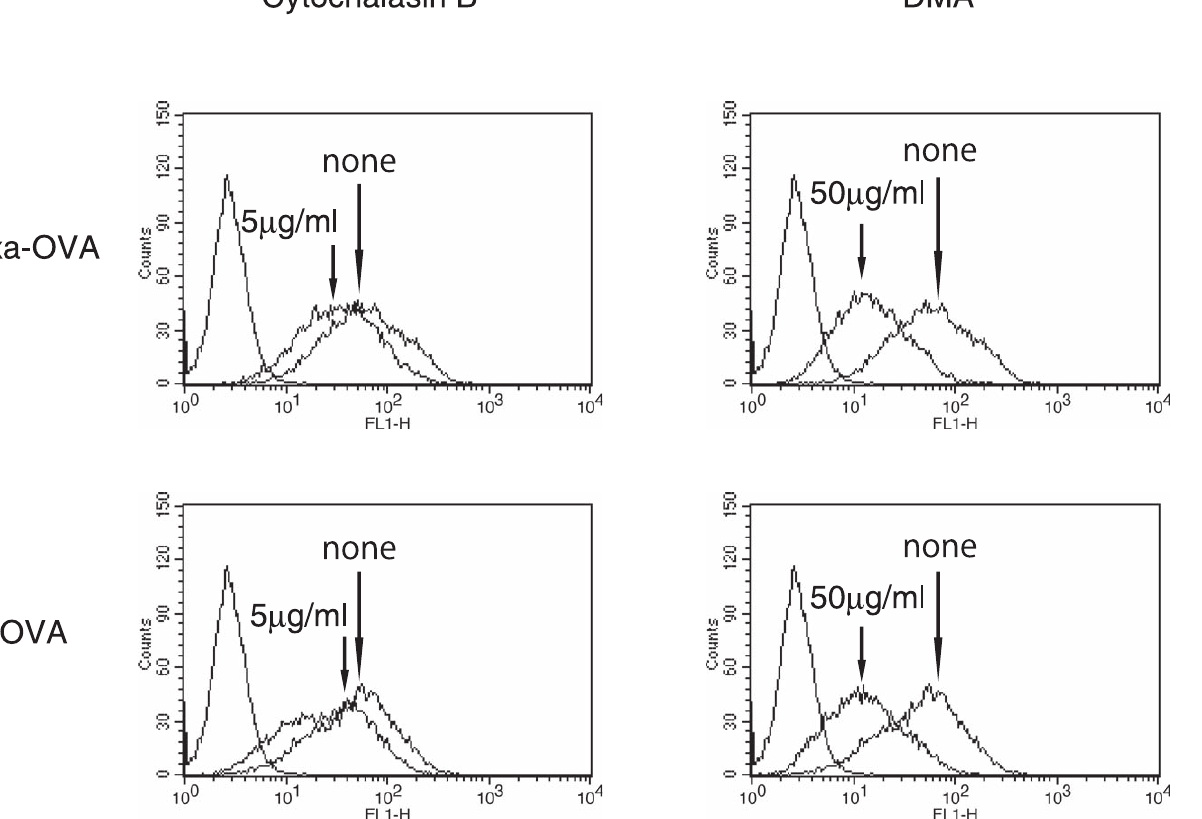
Figure 3. Influence of inhibitors for uptake of OVA coupled to oleoyl liposomes by macrophages. Alexa- or DQ-labeled OVA was coupled to oleoyl liposomes and added to the culture of macrophages as described in Materials and Methods. Treatment of macrophages with cytochalasin B or DMA was done 60 minutes prior to the addition of OVA-liposome conjugates.